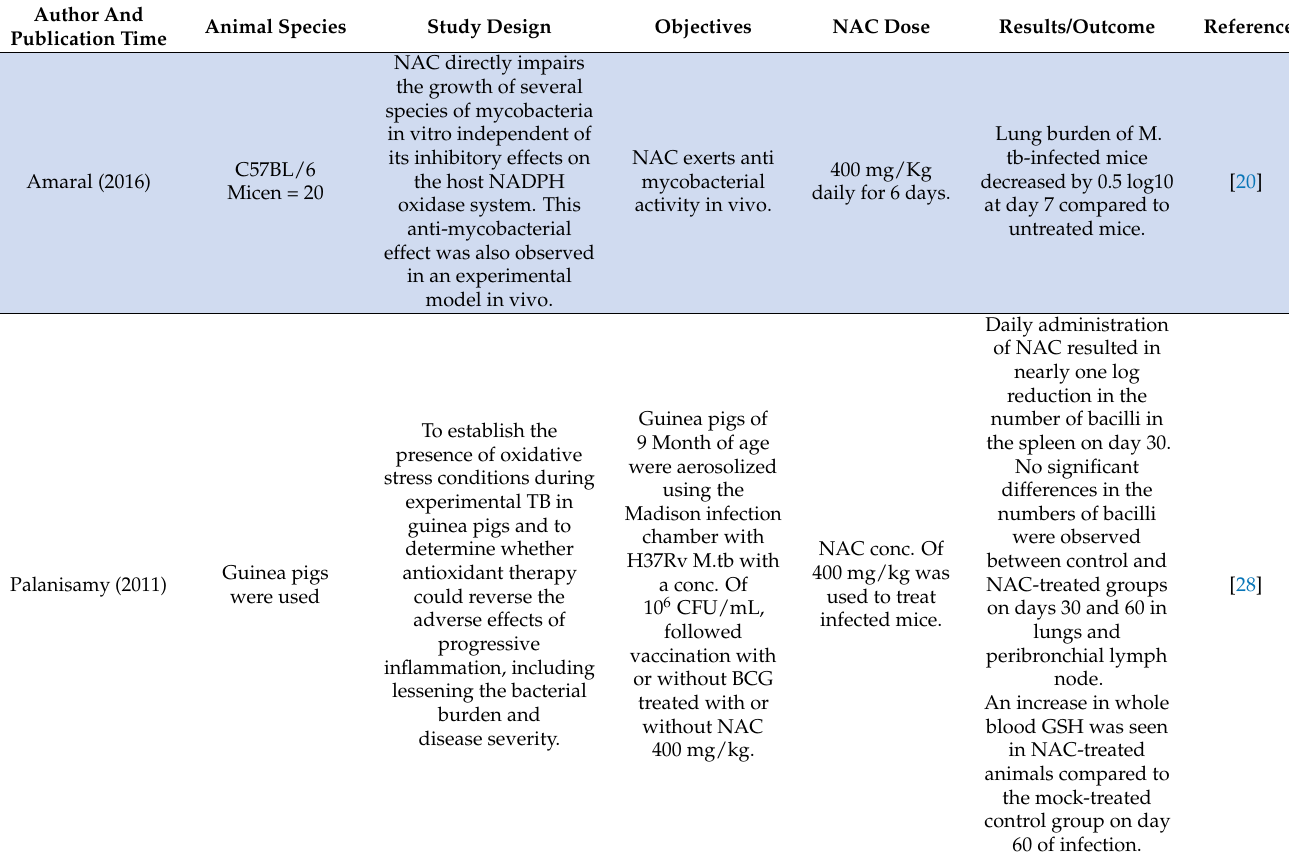
Table 2. Studies on experimental animal